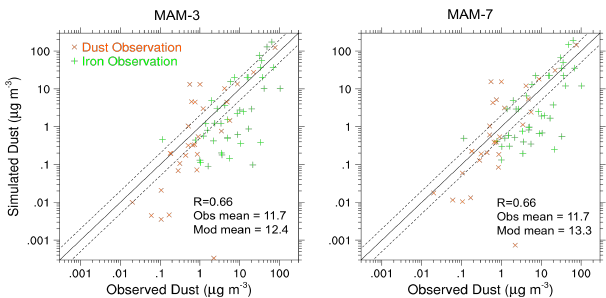
Fig. 18. Observed and simulated annual-average mineral dust con-